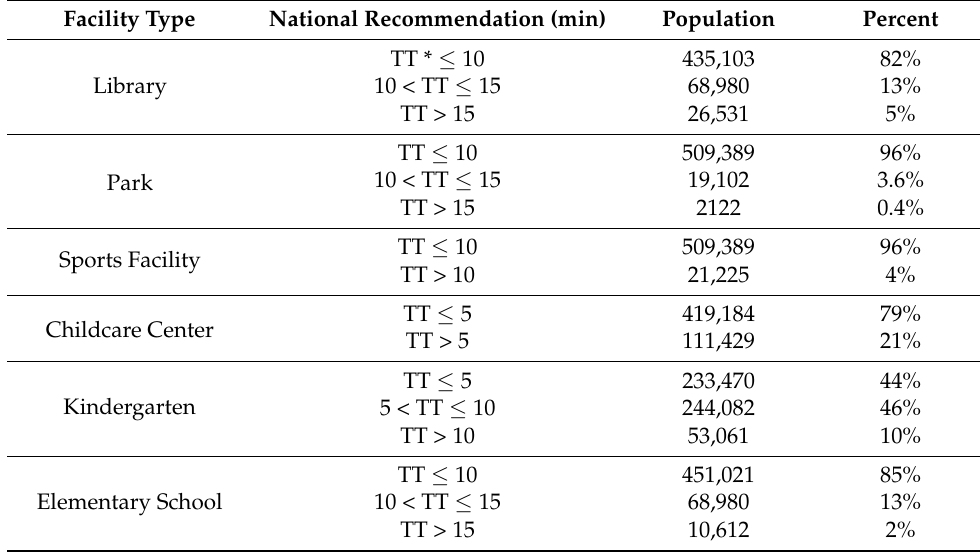
Table 5. Population by legend—walking time.